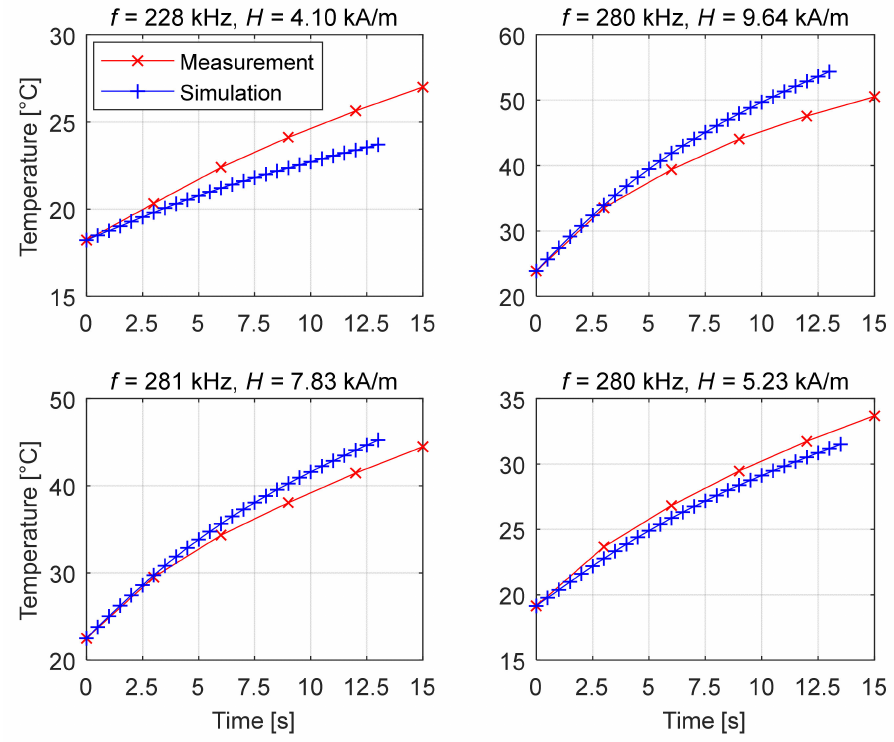
Figure 14. Comparison of time–temperature of measurement and simulation at the selected